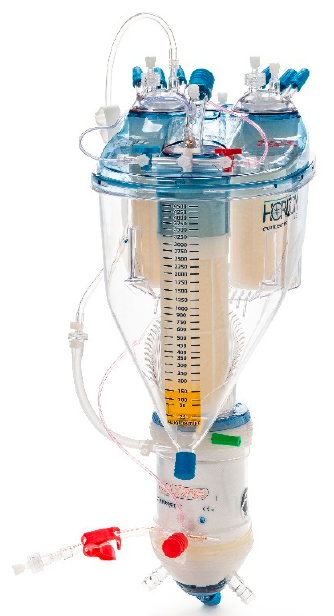
Figure 2. Horizon AF PLUS, Eurosets (venous reservoir and oxygenator).